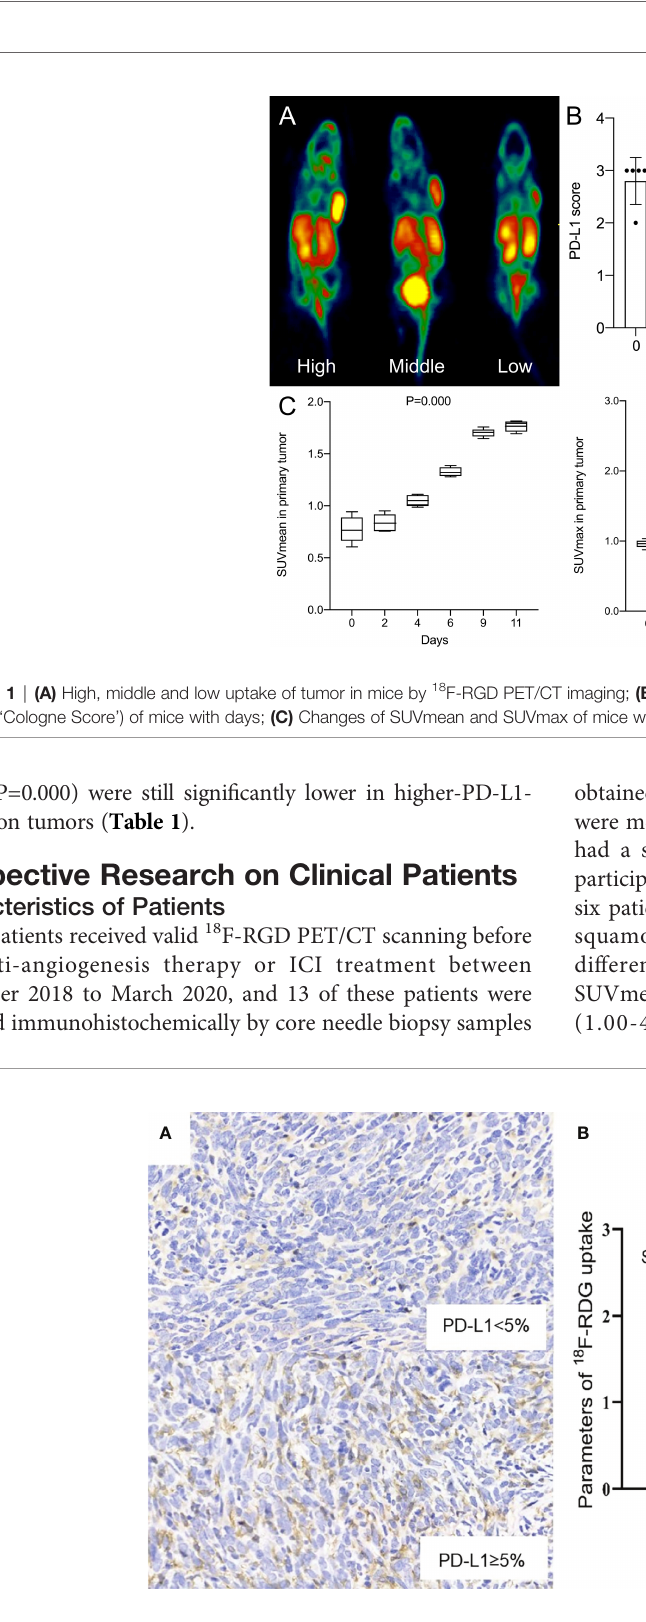
FIGURE 2 | (A) Relatively low and high expression of PD-L1 (×400). (B) Scatter diagrams of correlations between SUVmax, SUVmean and PD-L1 expression. P < 0.05 is considered statistically signi fi